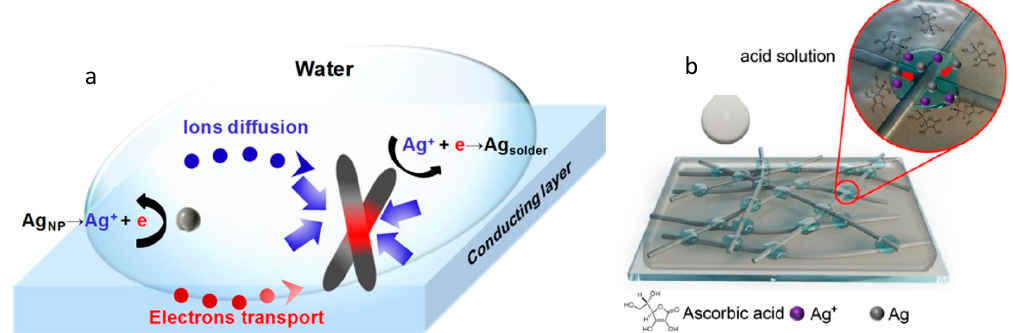
Figure 8. ( a ) Ag + ions di ff used from the AgNPs were reduced to Ag solders selectively at the junctions of crossing AgNWs. Reprinted with permission from [87]; Copyright 2018 American Chemical Society; ( b ) Reduction of Ag + ions on the nanoscale and self-limited Ag deposition at the junctions. Reprinted with permission from [17]; Copyright 2019 American Chemical